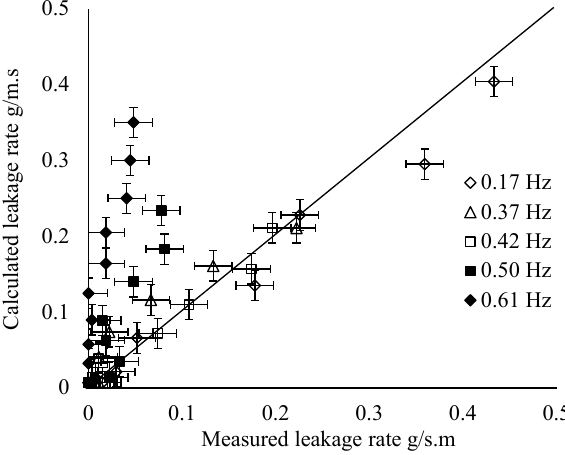
Figure 14. A comparison of measured and calculated leakage rates using a simplified model.